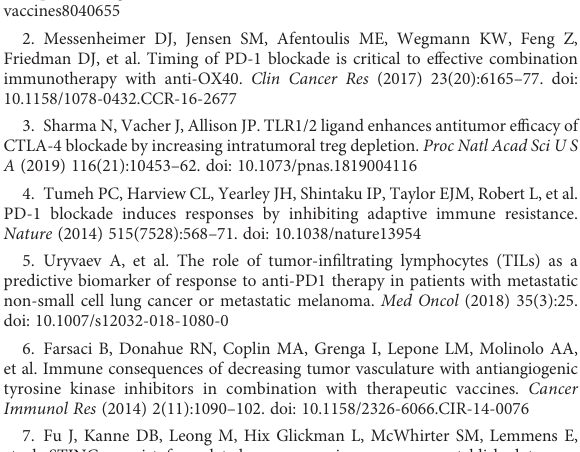
SUPPLEMENTARY FIGURE 4 Dose responses for murine bone marrow-derived macrophages (mBMDM) and human monocytic cell line THP-1. (A) Corresponding dose-response curves for CDN (STING) and R848 (TLR7/8) for the activation of mBMDM with saturation range in the red box. 10µg/mL was chosen for CDN, and 1µg/mL was chosen for R848. (B) 25µg/mL was chosen for CDN, and 25µg/mL was chosen for R848 for the activation of human monocytic cell line THP-1. SUPPLEMENTARY FIGURE 5 Gating for dendritic cells. Gating scheme for lymph node dendritic cells (CD11c+ MHCII+). SUPPLEMENTARY FIGURE 6 CDN andcombinationssaturateT-cellproliferation.CFSElowpercentage 5-dayspost-vaccinationwithcorrespondingvaccines.Alldataaregivenin mean ± S.D. *P < 0.05, **P < 0.01, ***P < 0.001, ****P < 0.0001, one-way analysis of variance (ANOVA) for multiple comparisons. SUPPLEMENTARY FIGURE 7 Gating for tumor immunophenotypingGating scheme for